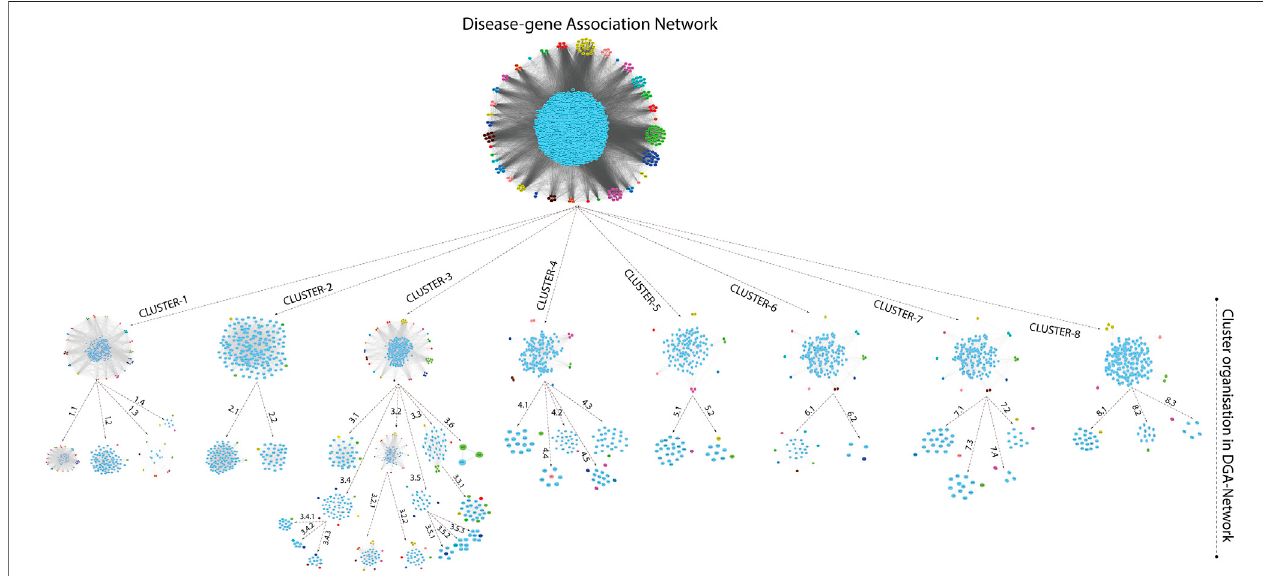
FIGURE 4 | Modules and sub-modules of the main network (Disease-genes network).